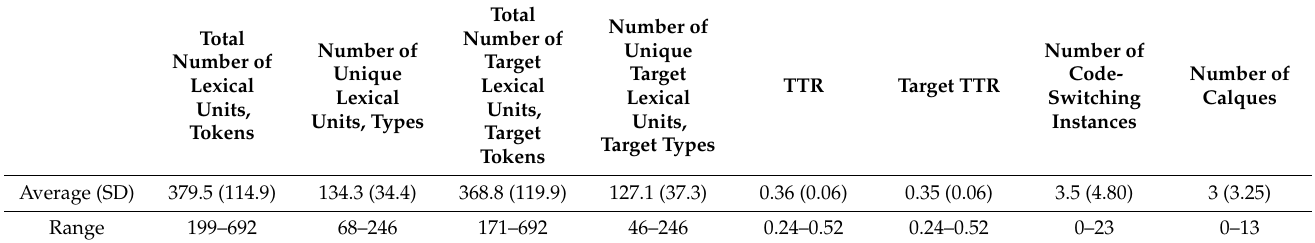
Table 4. Means and Ranges of Selected Narrative